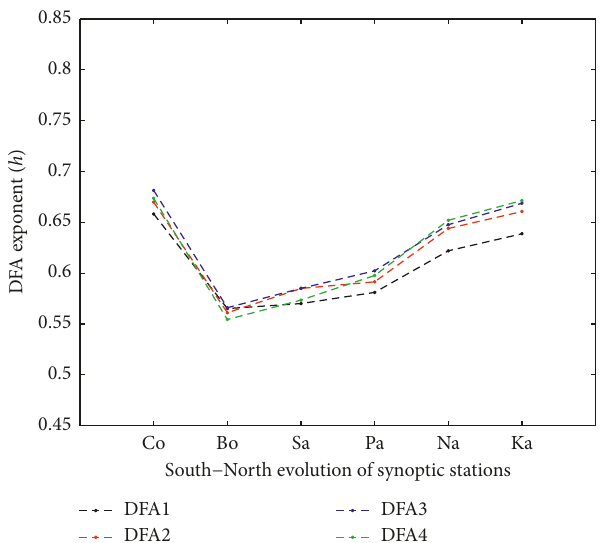
Figure 3: South-North distribution of DFA exponents ( ℎ ) obtained by the DFA1-4 method. Cotonou (Co), Bohicon (Bo), Sav`e (Sa), Parakou (Pa), Natitingou (Na), and Kandi (Ka). For a DFA m , an m-order polynomial is used to calculate the local trend in each segment.